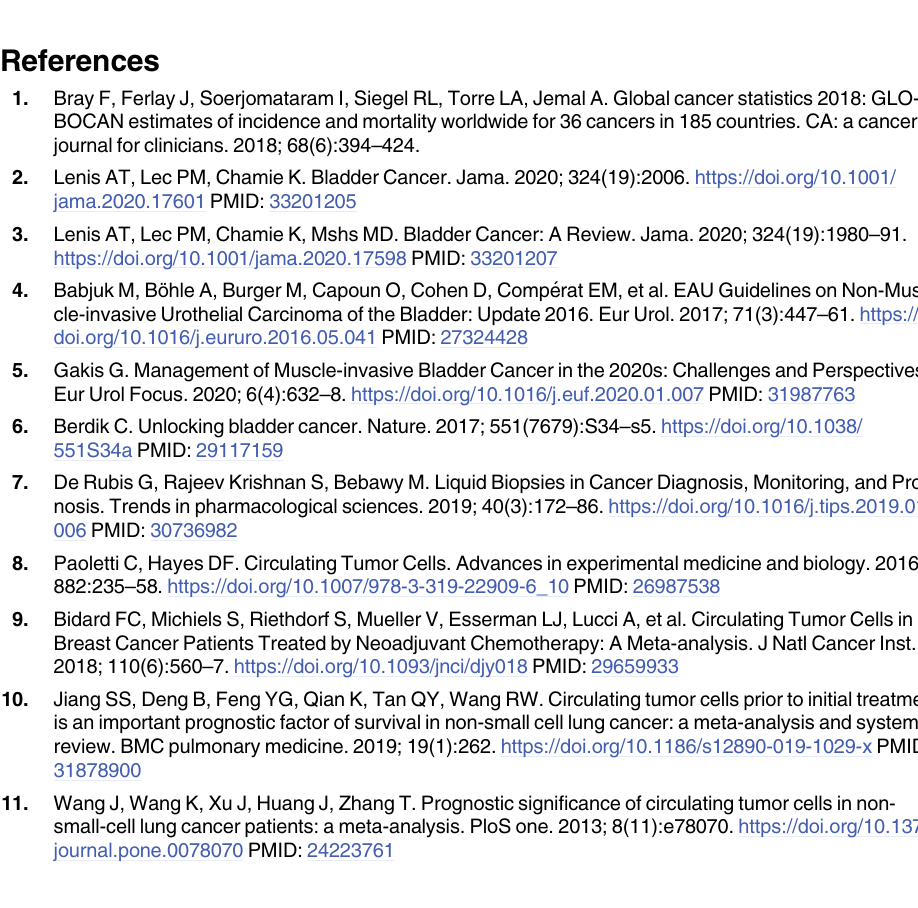
S2 Fig. Funnel plots for the publication bias in the DFS/RFS/TFR group. (TIF) S1 Table. Impact of CTC-positivity on the prognostic effects in